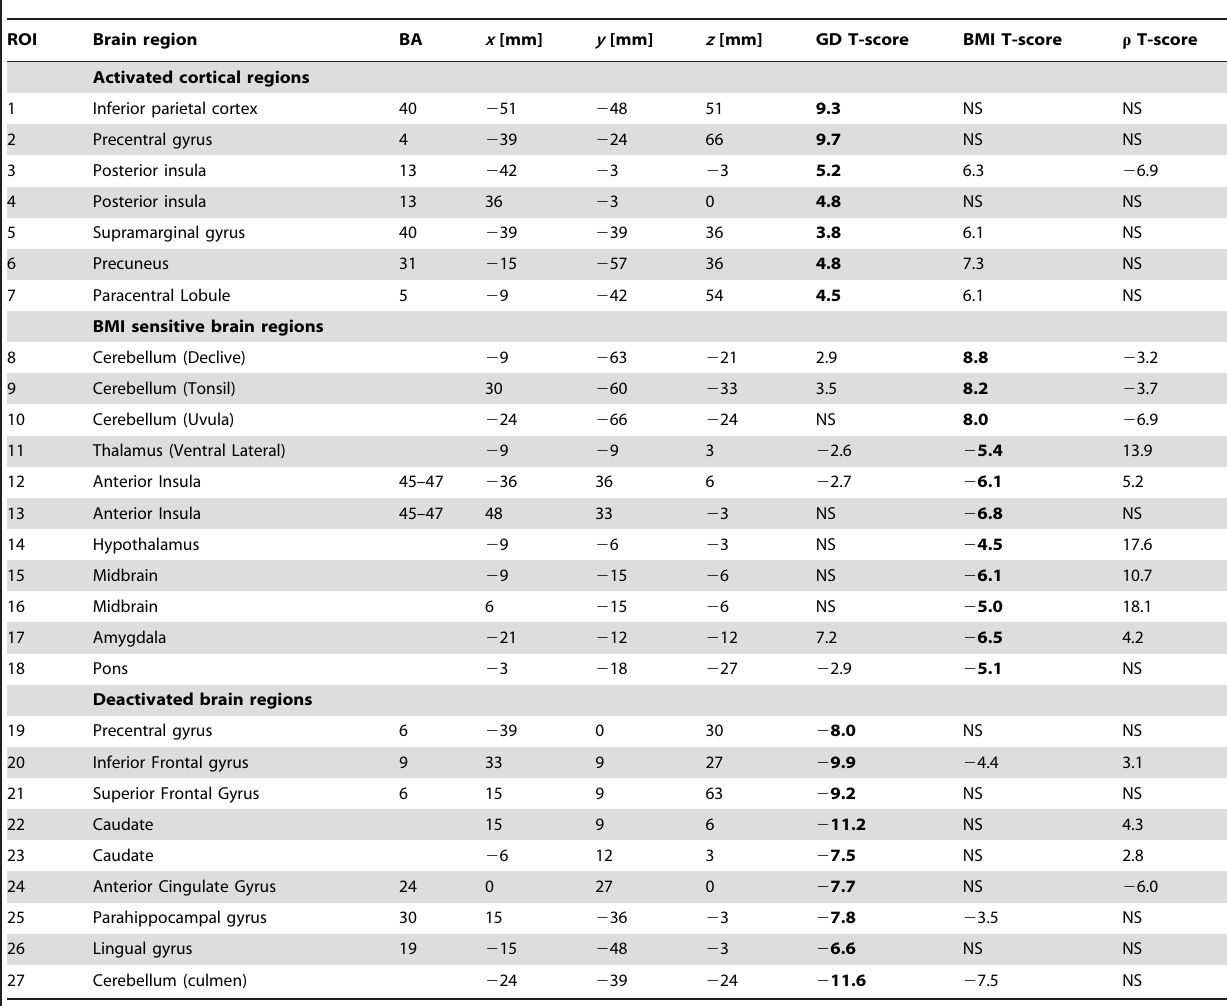
Average values in isotropic cubic ROIs (27 voxels; 0.73 cc) centered at the ( x , y , z ) coordinates. Sample size=24 healthy subjects.